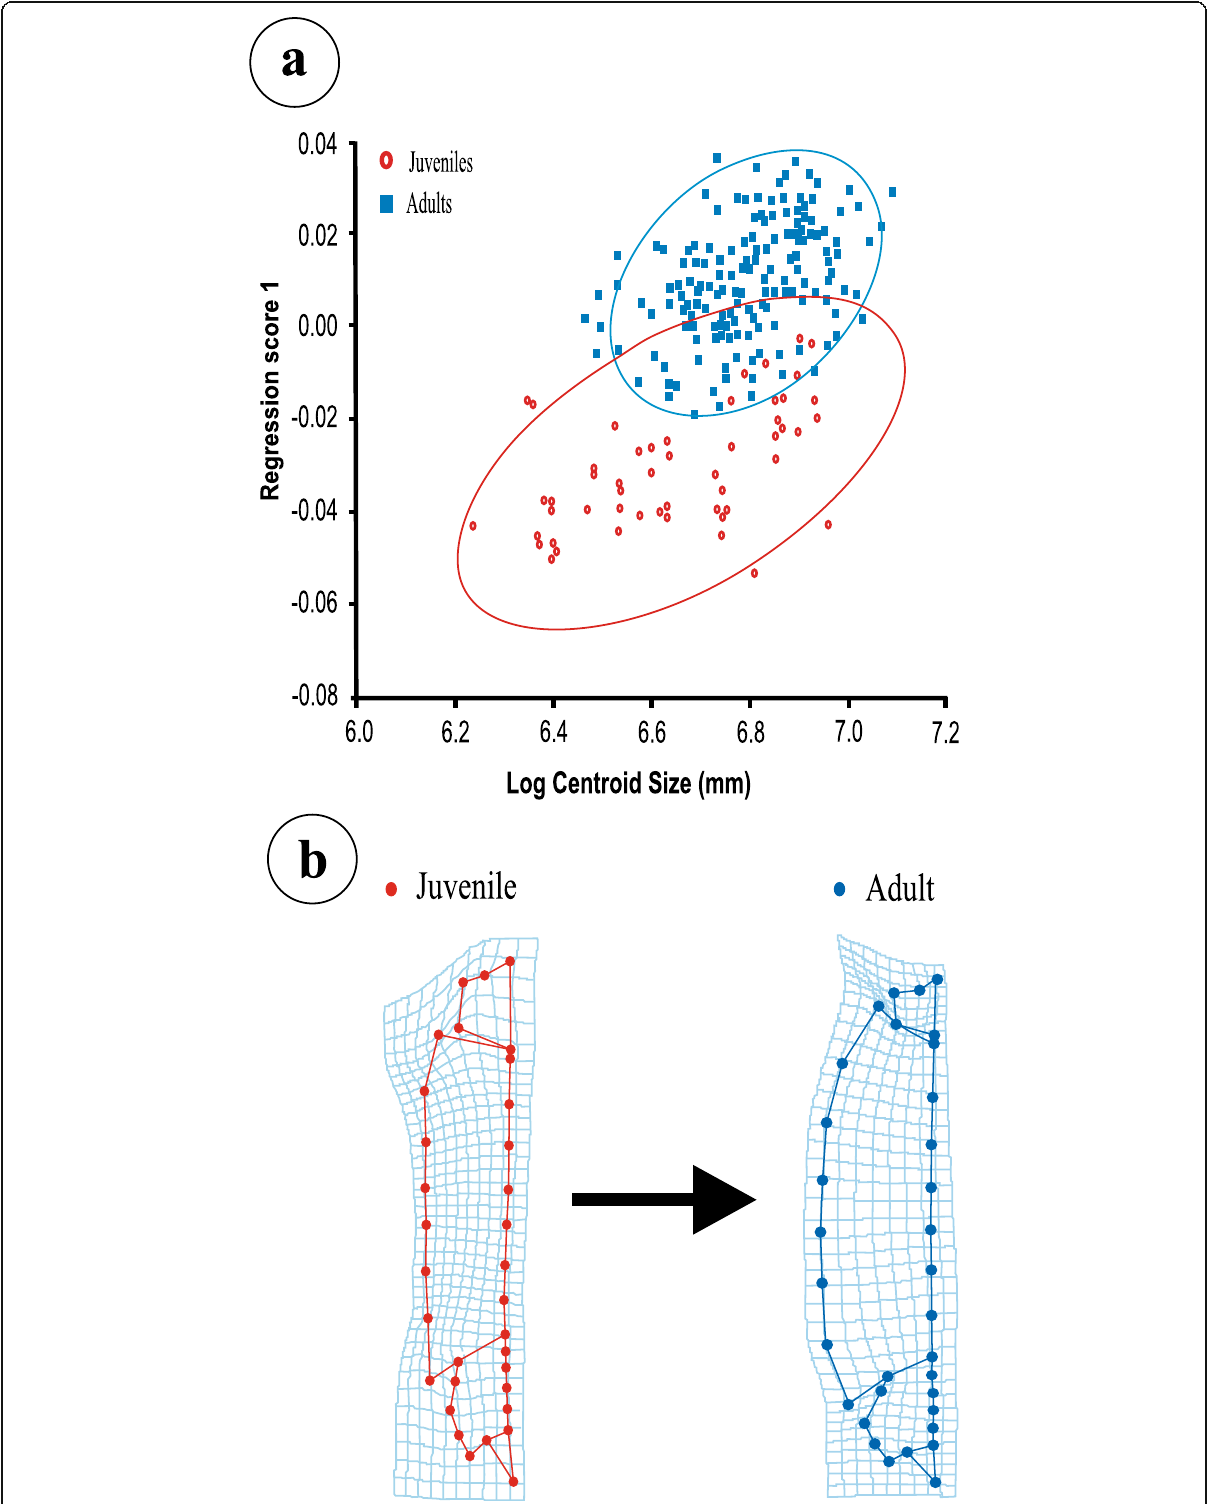
Fig. 5 a Scatterplot of multivariate regression of shape variables onto log CS showing ontogenetic allometry of P. pruinosus . b Thin plate spline deformation grids showing shape changes from the average shape predicted by multivariate regression analysis for juvenile and adult of P. pruinosus at 6.3 and 7.1 units of log